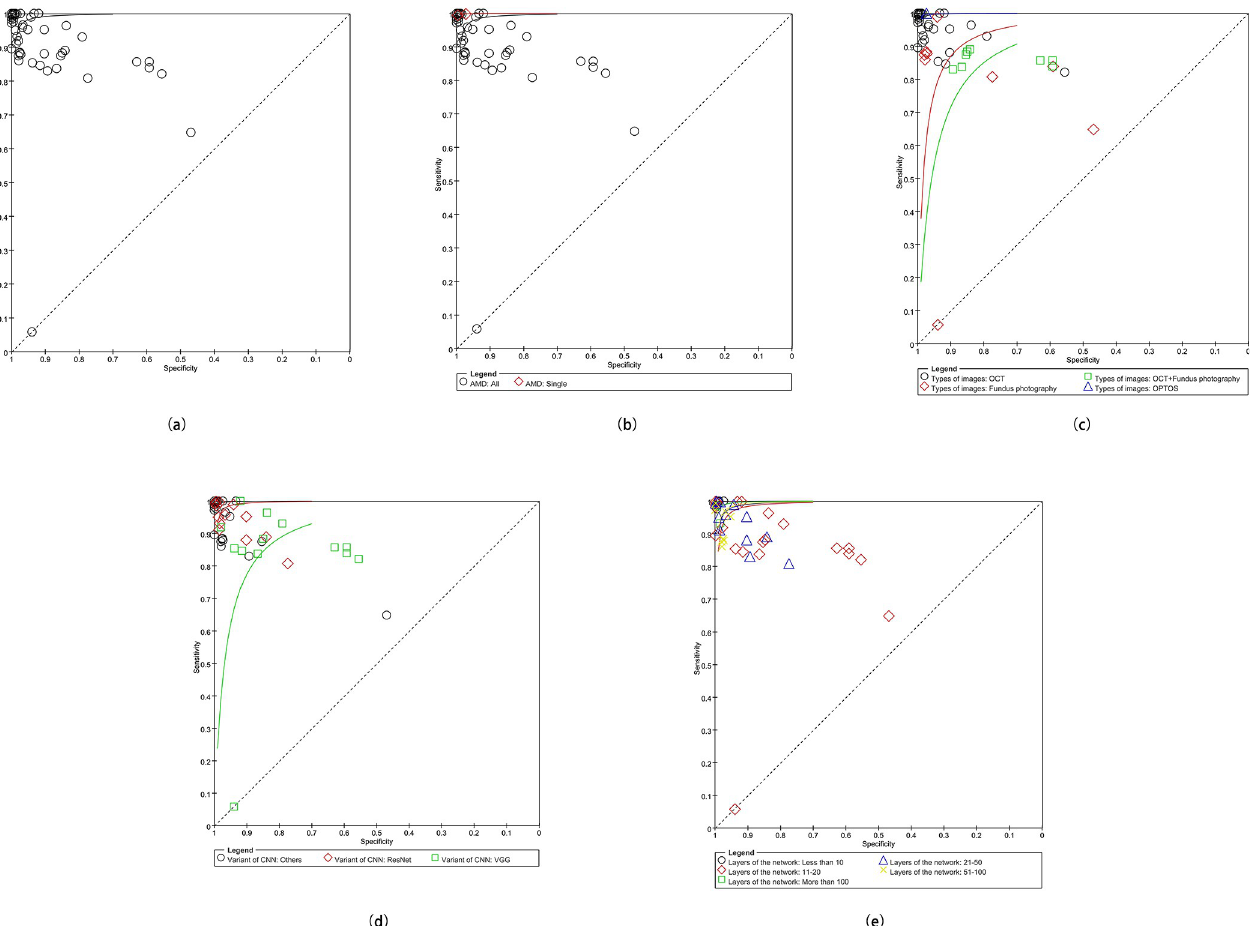
Fig 5. The SROC (a) the pooled SROC; (b) the SROC of types of AMD; (c) the SROC of types of images; (d) the SROC of variants of CNNs; (e) the SROC of